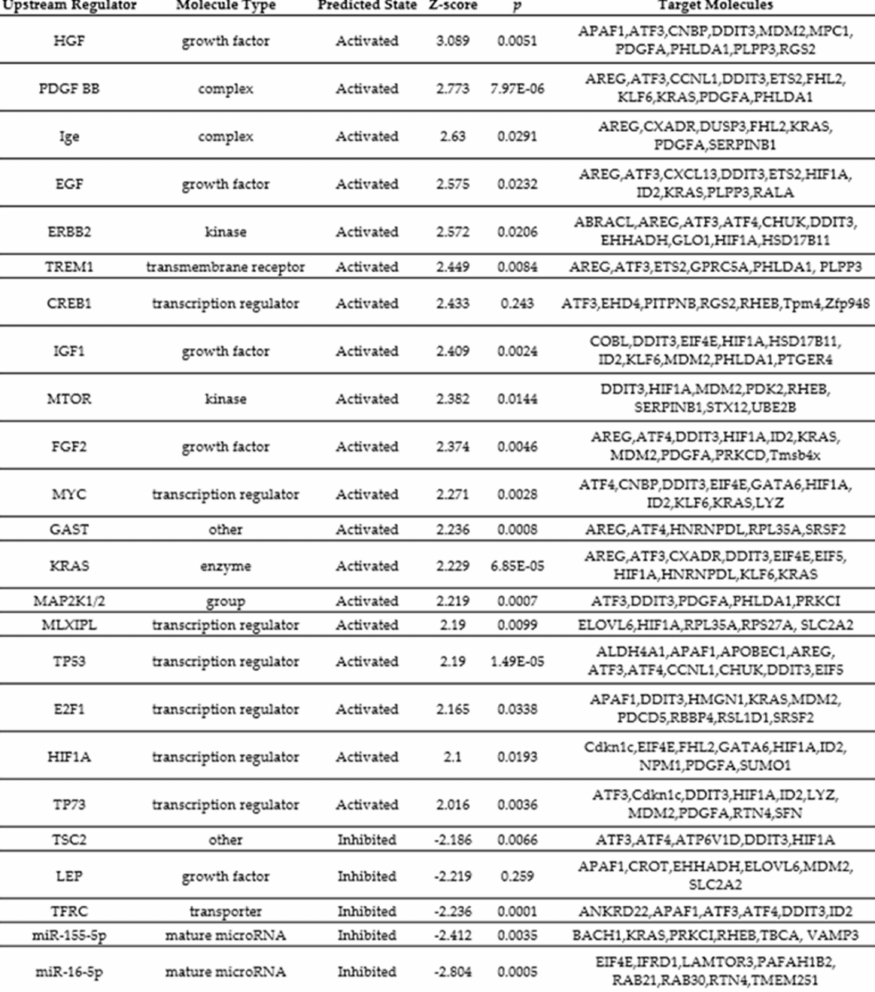
Figure 8. Top biological processes in HA 35 KDa-treated pups compared to controls. The pre- dicted GO categories were ranked by enrichment score ( − log ( p -value)) HA: hyaluronic acid; GO: gene